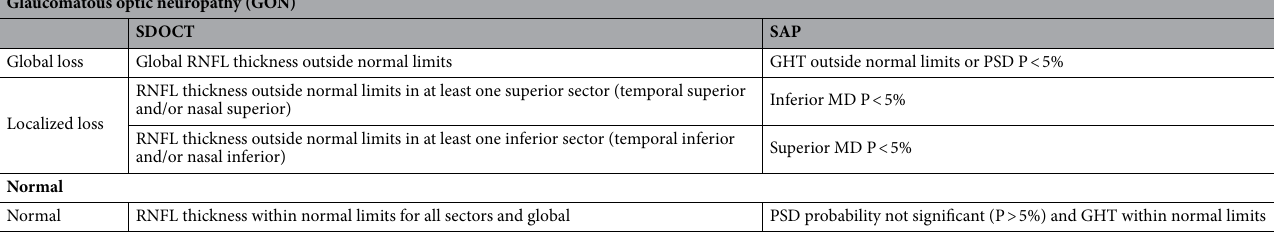
Table 1. Summary of criteria for the objective definition of glaucomatous optic neuropathy (GON). Structural and functional criteria are derived from spectral-domain optical coherence tomography (SDOCT) and standard automated perimetry (SAP) results, respectively. To be considered glaucoma, it was necessary to meet the criteria for global or localized loss. To be considered normal, it was required that both SDOCT and SAP results were normal. SDOCT-SAP pairs that did not meet the criteria for either groups were considered suspects. SDOCT spectral-domain optical coherence tomography, SAP standard automated perimetry,